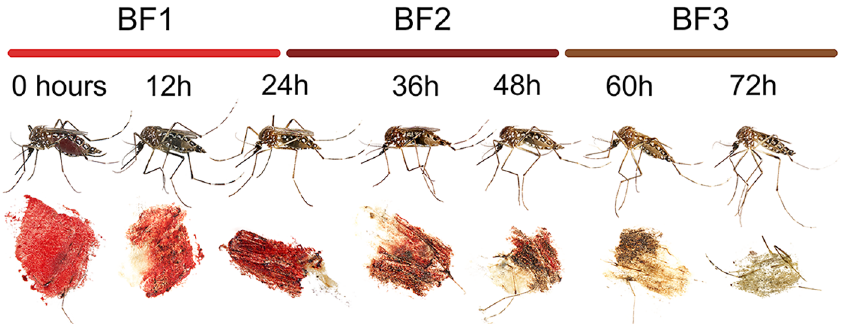
Fig 1. Blood meal scoring scheme, modified from Detinova [34], to estimate the extent of digestion in blood fed mosquitoes. Fresh blood meals were categorized as BF1, and were characterized by a large size, bright red color, and the absence of developing ovaries. Blood meals categorized as BF2 were intermediate in digestion extent, and had darker red blood meals with developing ovaries not taking up more than 50% of the abdomen. Blood meals categorized as BF3 were in later stages of digestion, brown in color, and had ovaries that took up more than 50% of the abdomen. This is illustrated with blood fed Aedes aegypti killed between 0 and 72 h